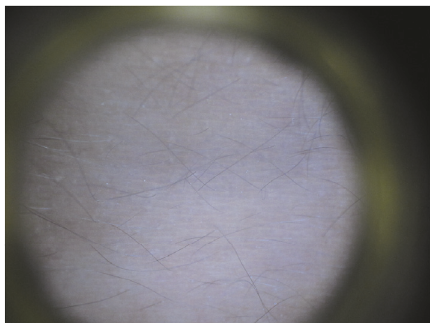
Figure 4: Dermoscopy of a lesion showed gray-blue to bluish small dots over a bluish background, corresponding to melanin-laden melanophages in deeper dermis (Tyndall